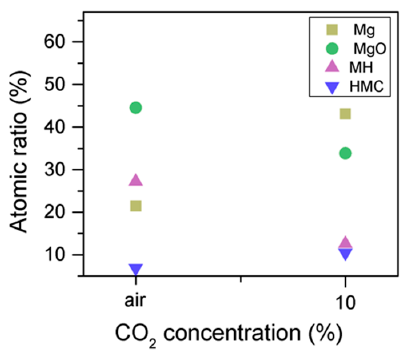
Figure 8. Mg2p concentration for samples exposed to air and CO 2 for seven days.